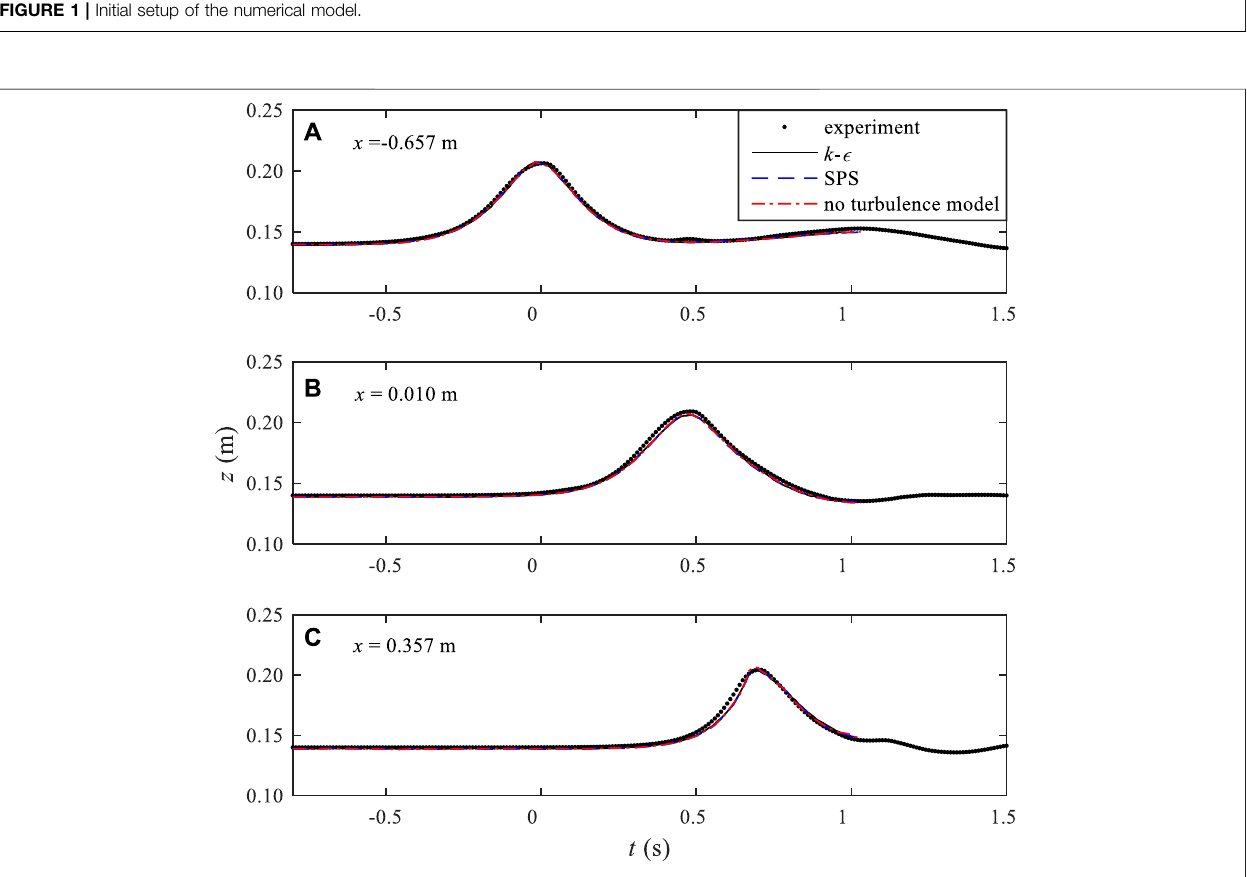
FIGURE 1 | Initial setup of the numerical model.